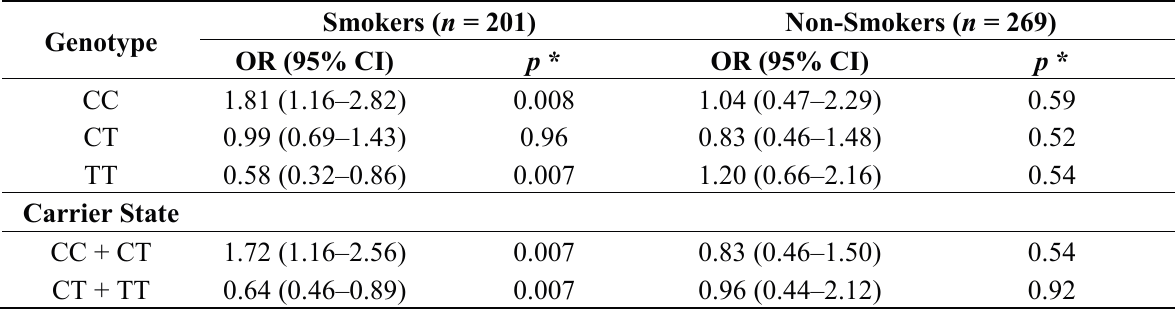
Table 7. The influence of genotype variants of the USF1 gene rs2516839 polymorphism on triglyceride levels increase in subgroups of smokers and